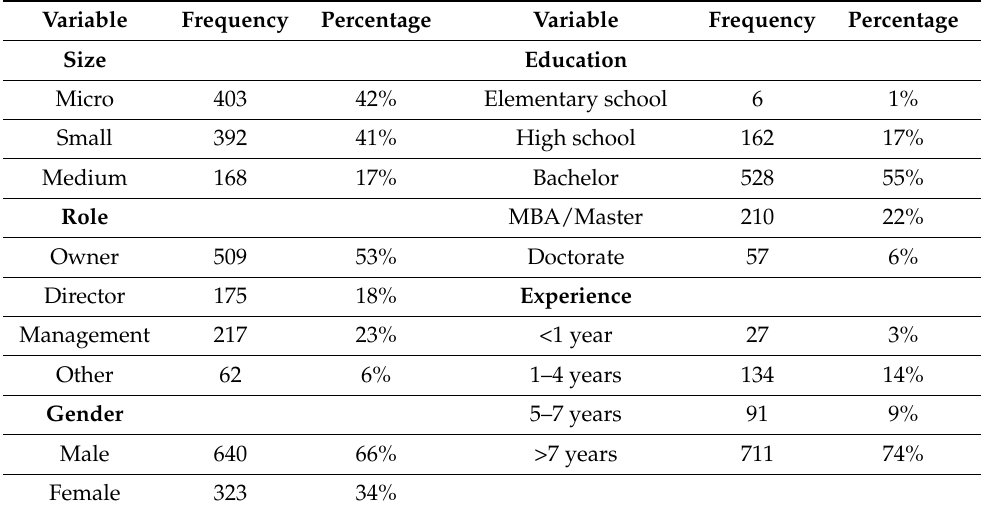
Table 1. Demographics: firm and entrepreneurs’ characteristics ( n =